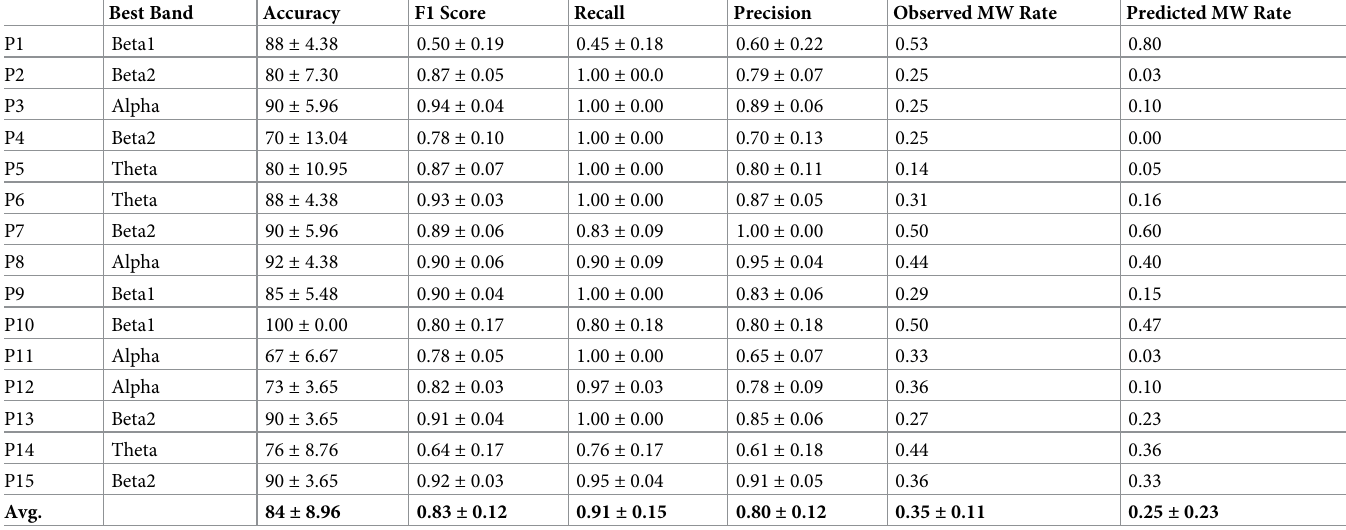
Table 6. Classification performance (with standard error across cross-validation runs) for the best frequency band using the common spatial pattern algorithm with the Artifacts Suppressed approach. Frequency band chosen based on F1 score. Average performance (with standard deviation across participants) is given by the best frequency band for each participant. Observed MW rate reflects the MW rate of the processed epochs after epoch removal, and therefore may not be the exact rate of MW observed in the probe responses. Predicted MW rate is the rate at which the machine learning model predicts MW. Best Band Accuracy F1 Score Recall Precision Observed MW Rate Predicted MW